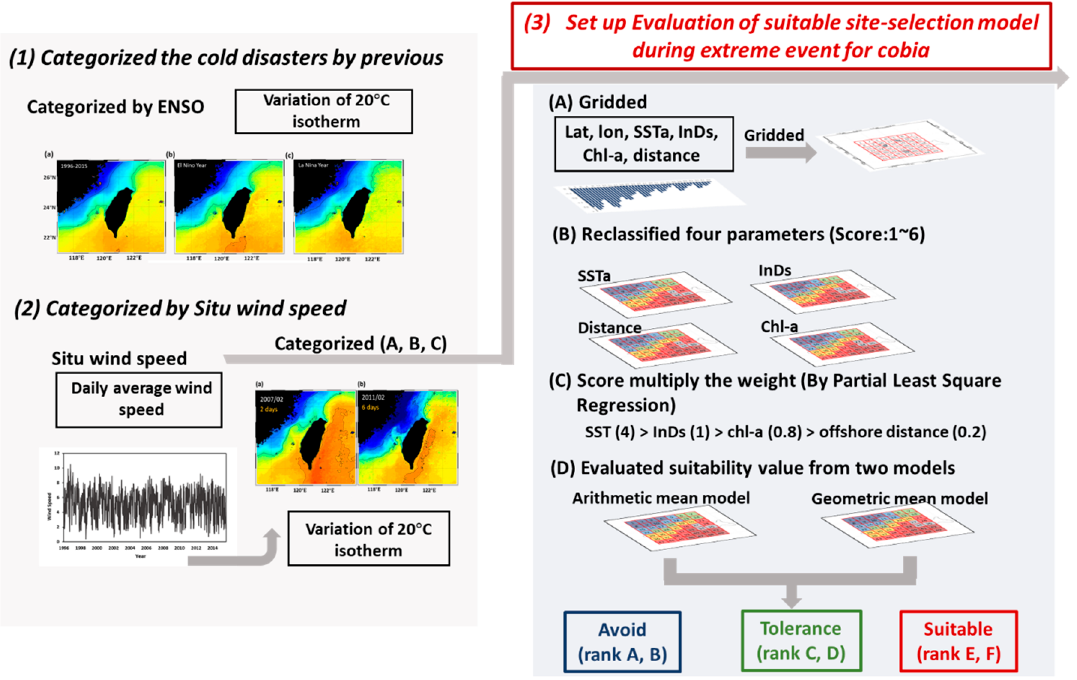
Figure 2. Schematic of the evaluation of site selection maps for cobia cage culture in the inner bay of the Penghu Islands.